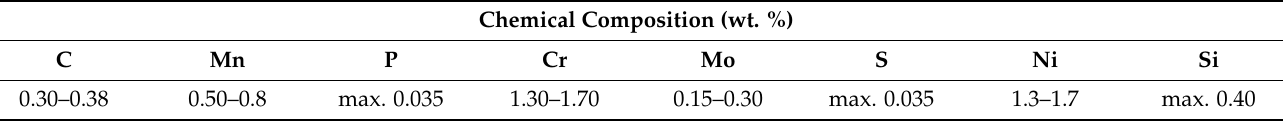
Table 2. The chemical composition of the 1.6582 steel according to EN 10027-2. Chemical Composition (wt.